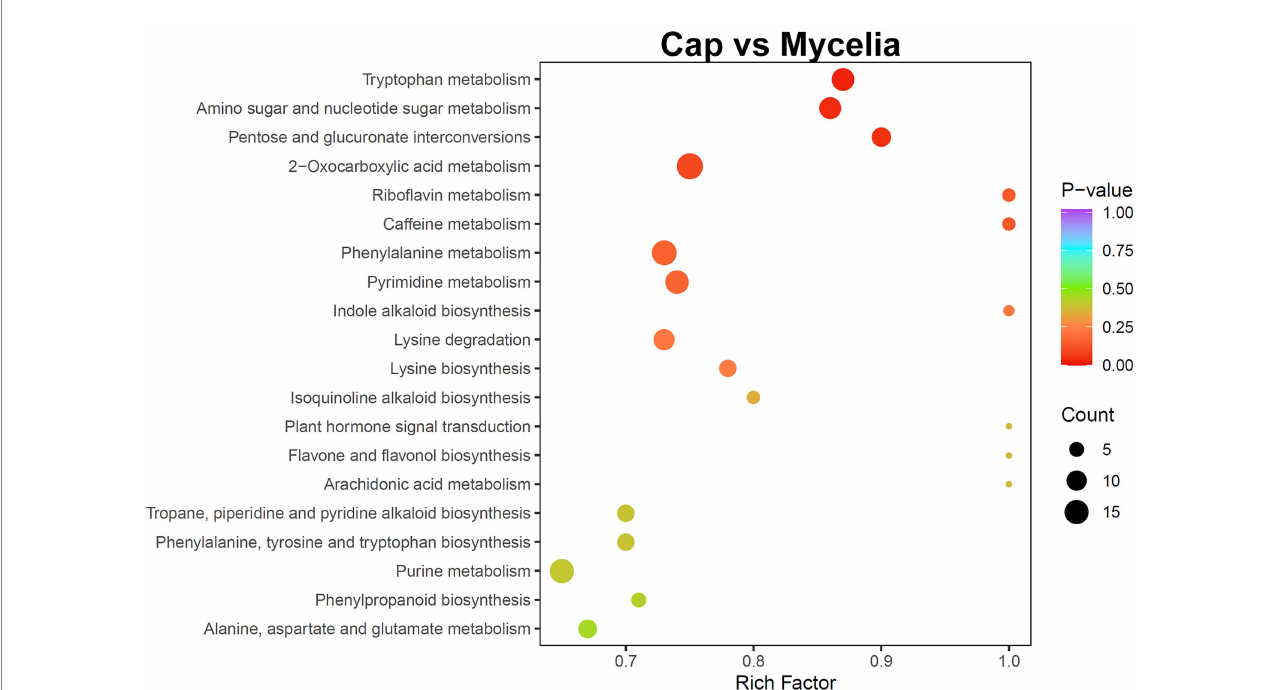
FIGURE 8 KEGG pathway enrichment analysis of the metabolome between cap and mycelia. The abscissa represents the rich factor of each pathway, and the ordinate represents the pathway name (sorted by value of p ). The color of the dots reflects the value of p ; the redder the dots, the more significant the enrichment. The dot size represents the number of differential metabolites enriched in the pathway.